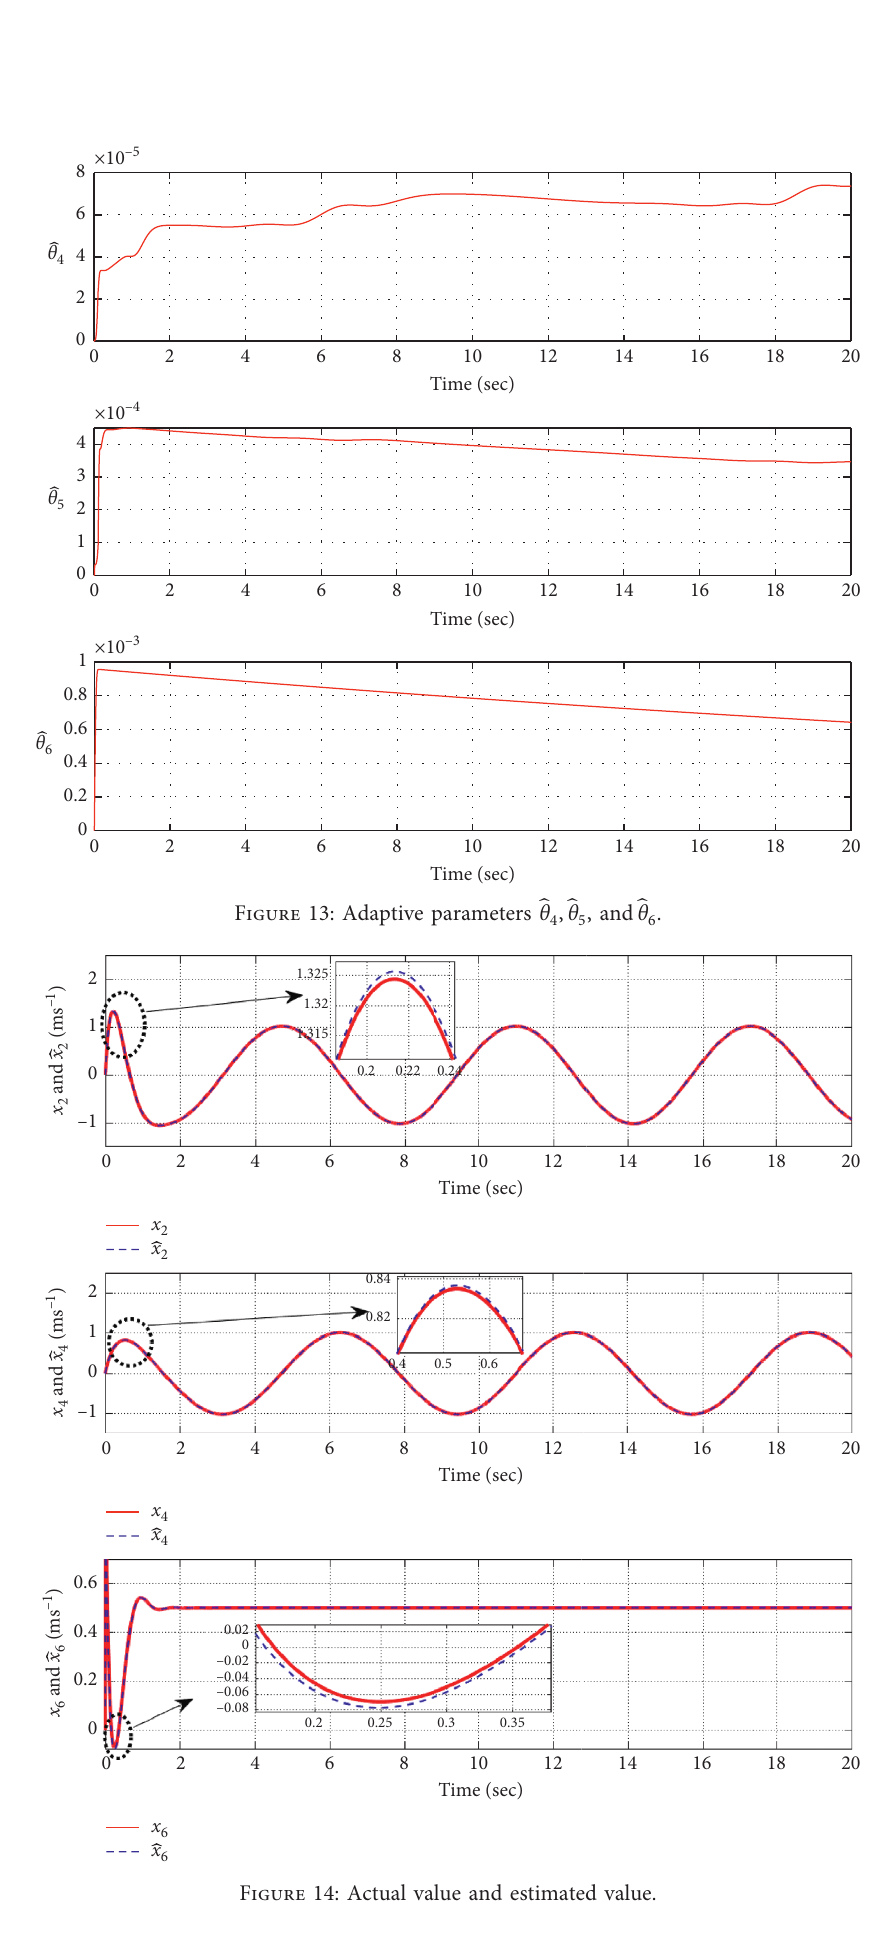
Figure 14: Actual value and estimated